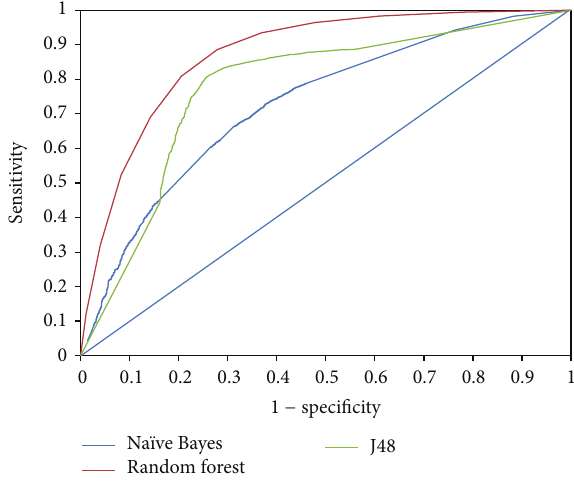
Figure 2: Comparison of the performance of three classifiers based on ROC (receiver operating characteristics)